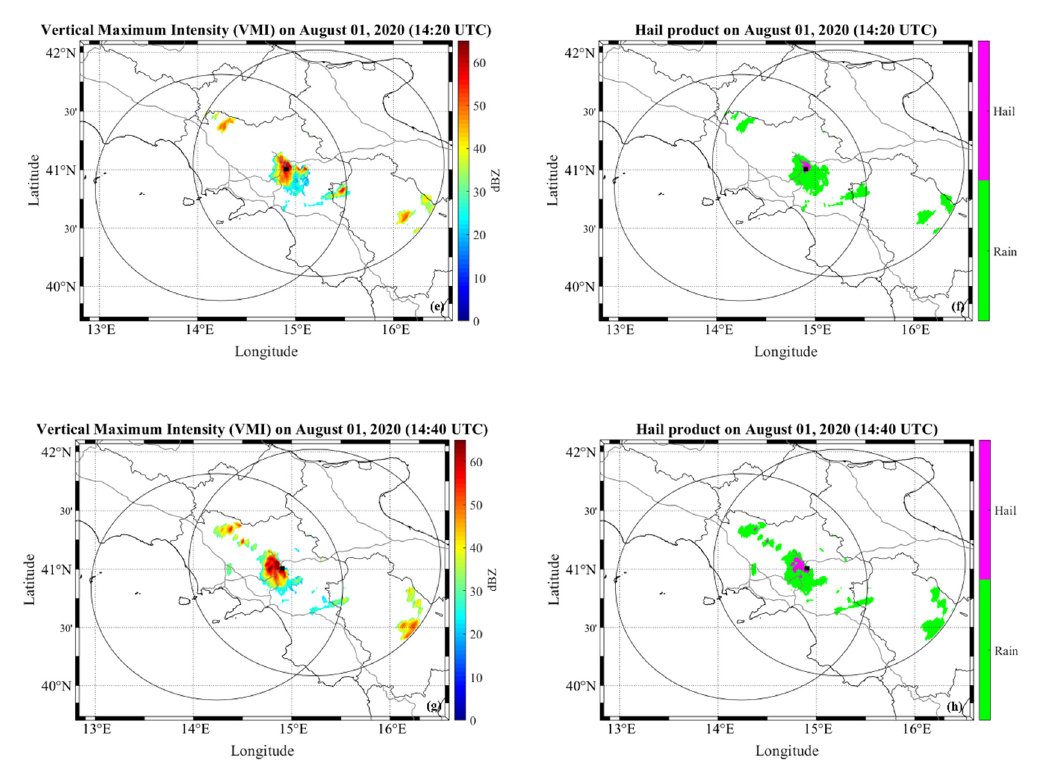
Figure 11. Sequence of images from the CARMEN project X-band radar composite showing the evolution of hailstorms that occurred in Irpinia on 1 August 2020. In the left panels ( a , c , e , g ), the Vertically Maximum Intensity ( VMI ) product obtained at 13:40 UTC ( a ), 14:00 UTC ( c ), 14:20 UTC ( e ) and 14:40 ( g ) is shown. In the right panels ( b , d , f , h ), the Hail Product determined from the Vertically Integrated Liquid Density ( VLD ) method is presented for the same times. The VMI is expressed in dBZ and is color coded according to the vertical bar. In the right panels, the areas where hail is likely to occur (i.e., where the POH index is above the warning threshold) are indicated in magenta, while the areas where hail is not expected (i.e., where the POH index is below the warning threshold) in green. The hailstorm affected a small sector of the A16 highway, including the Montemiletto pass (whose position is marked as a black filled-in square). The highways are marked as grey lines, whereas the black circles represent the maximum radar range for Naples and Trevico systems.